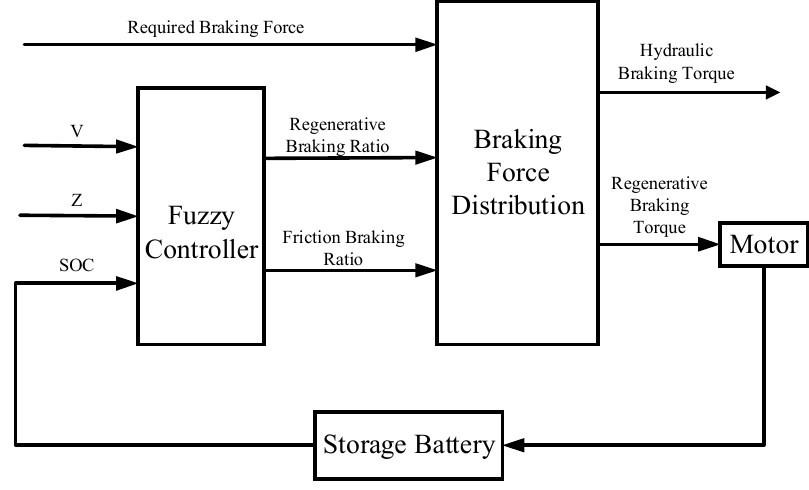
Figure 6. Braking energy recovery strategy.